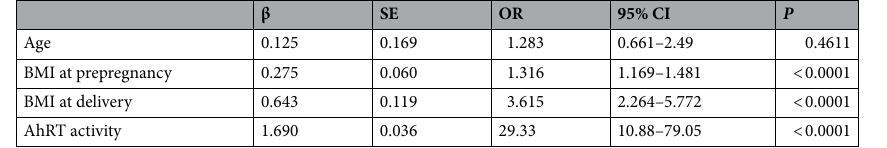
Table 3. Multiple logistic regression analysis of gestational diabetes mellitus. The cutoffs are following: 35 years old for age; 22.0 and 25.0 kg/m 2 for body mass index (BMI) at prepregnancy and at delivery, respectively; and 2.0-fold induction for aryl hydrocarbon receptor transactivating (AhRT) activity. Adjusted for age, blood glucose at OGTT 50 g, HOMA-IR, systolic blood pressure, diastolic blood pressure, and BMI at prepregnancy and at delivery.